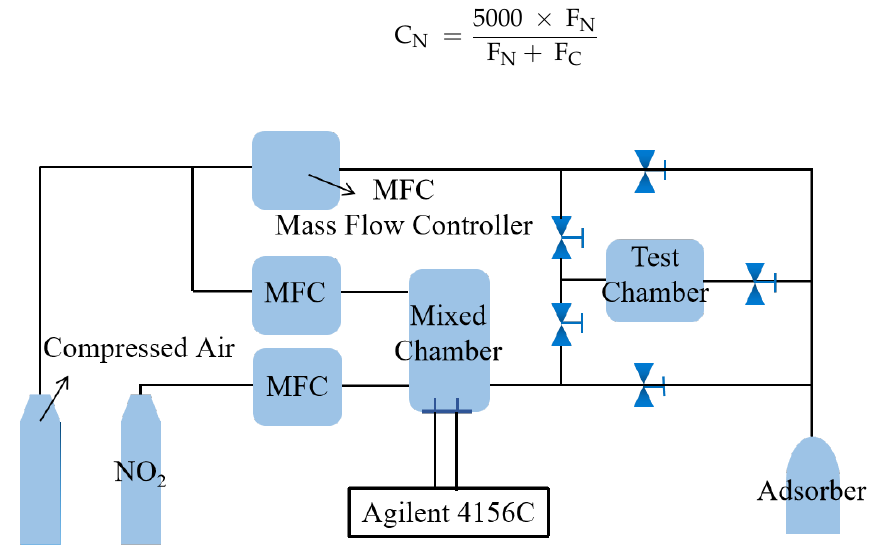
Figure 2. Schematic illustration of the gas sensing system.